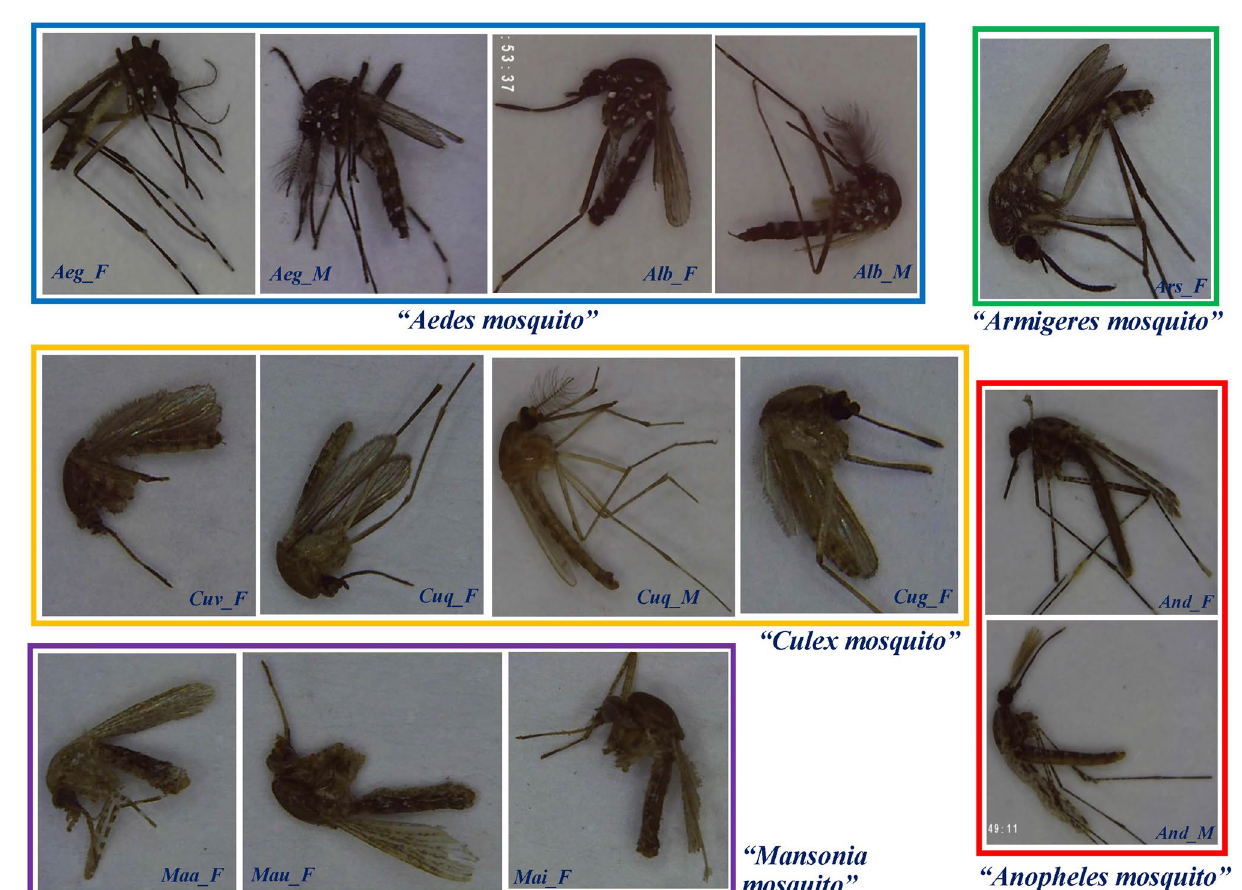
Figure 2. Sample categories. Wild-caught mosquitoes include Aeg_F (Ae. aegypti female), Aeg_M (Ae. aegypti male), Alb_F (Ae. albopictus female), Ars_F (Armigeres subalbatus female), And_F (An. dirus female), And_M (An. dirus male), Cuv_F (Cu. vishnui female), Cuq_F (Cu. quinquefasciatus female), Cuq_M (Cu. quinquefasciatus male), Cug_F (Cu. gelidus female), Maa_F (Mansonia annularis female), Mau_F (Ma. uniformis female) and Mai_F (Ma. indiana female). All photographs were taken by Veerayuth Kittichai, the first author in the manuscript, at Bangkok area,